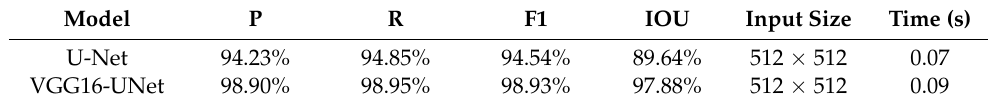
Table 2. Comparison of the test set’s evaluation metrics for the two models.